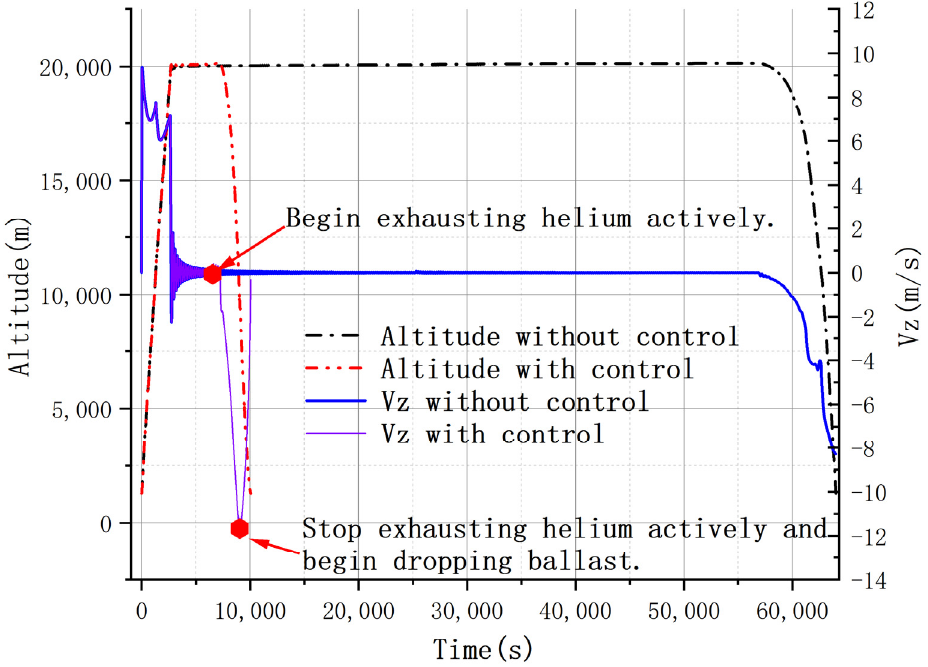
Figure 18. Simulation results of Mission C: balloon system’s change in vertical speed vs. time and change in altitude vs. time while the control strategies are applied (or not).